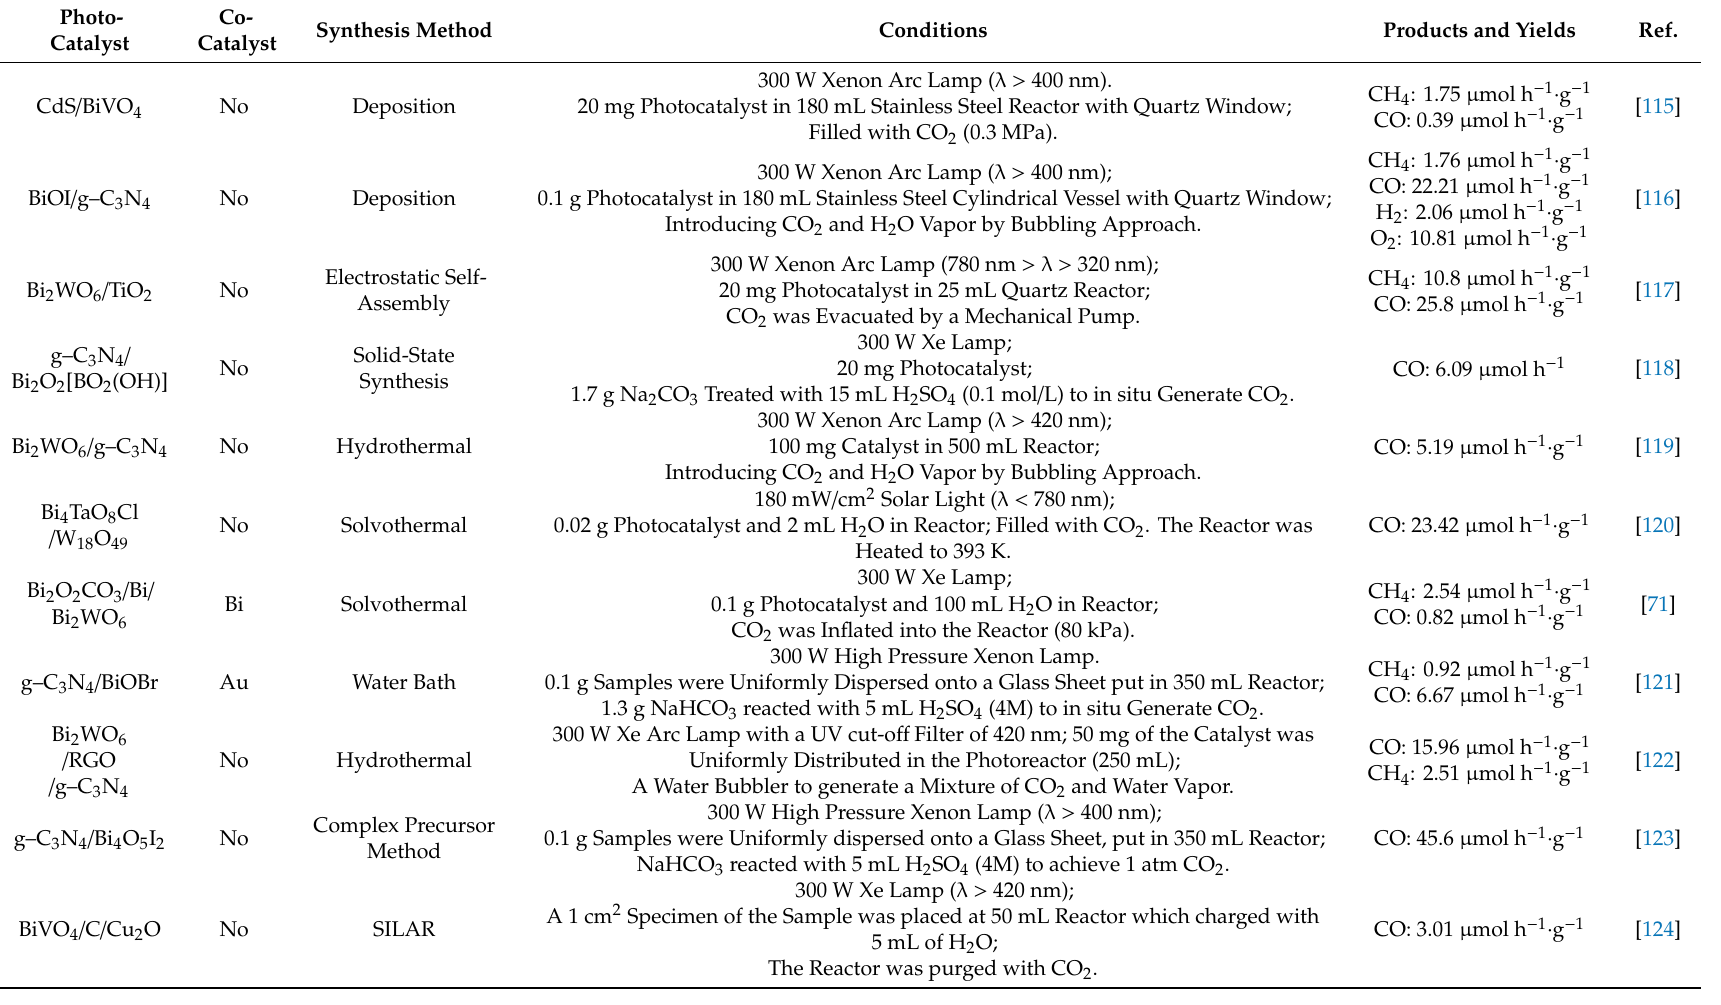
Table 4. The research progress of Bi-based Z-scheme photocatalyst in CO 2